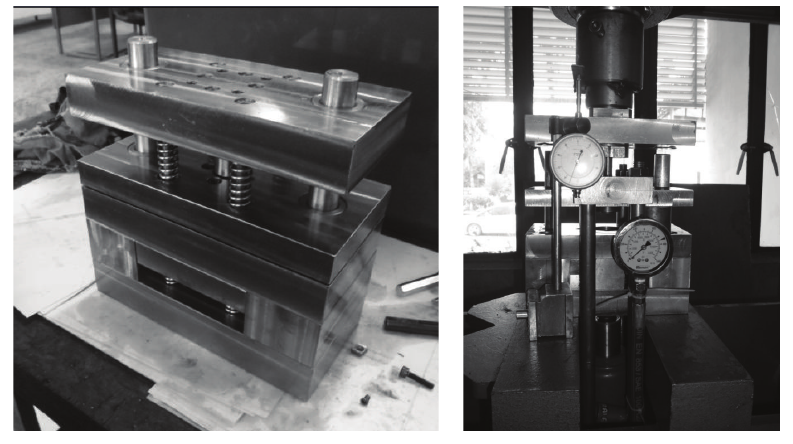
Figure 2: Equipment and tools used in experiment.